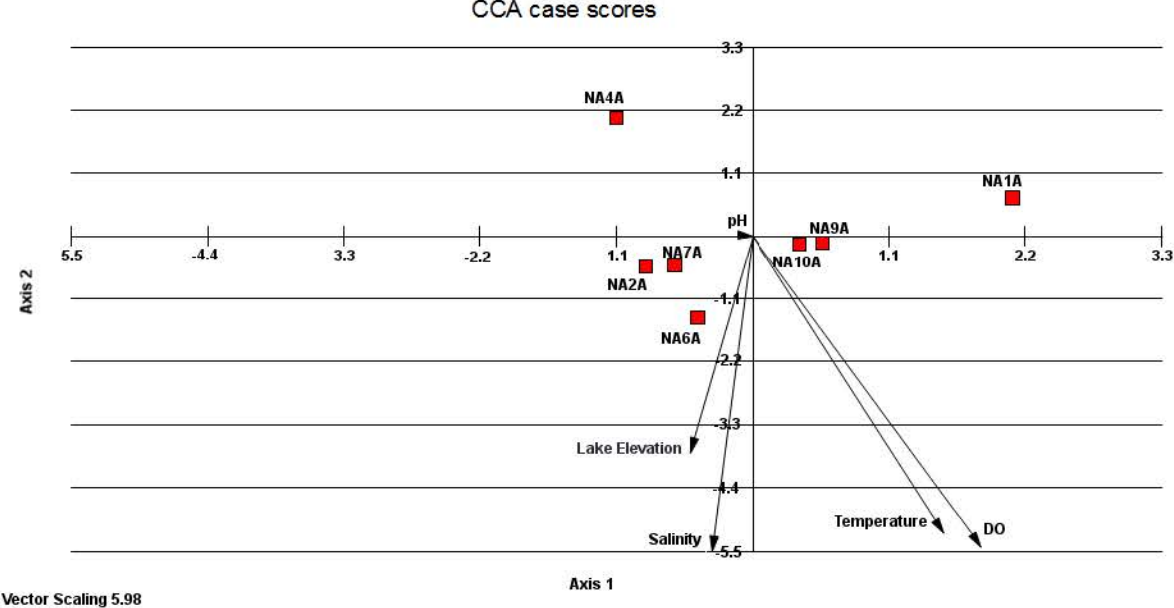
Figure 5. Canonical Correspondence Analysis ordination diagram with relative abundance of seven archaeal communities (squares) and environmental variables (arrows). The cumulative percentage for axis 1 and axis 2 are 26.55 and 33.13 respectively. The seven clone libraries are NA1A (June-2003) NA2A (October-2003), NA4A (June-2004), NA6A (February-2005), NA7A (June-2005) NA9A (June-2006), NA10A